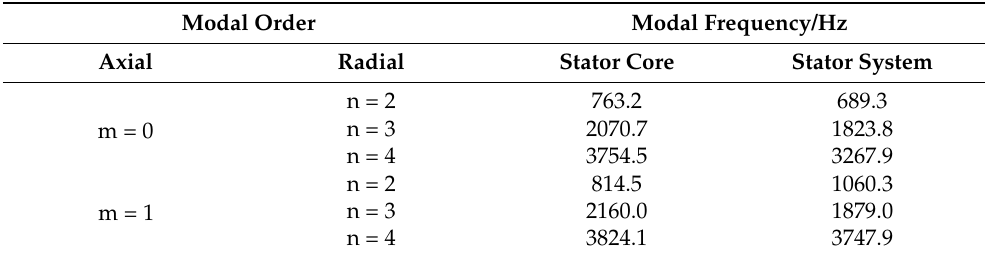
Figure 4. Stator core and stator system modal test. ( a ) Modal experiment of stator core; ( b ) Modal experiment of stator system. Table 3. Modal test results.